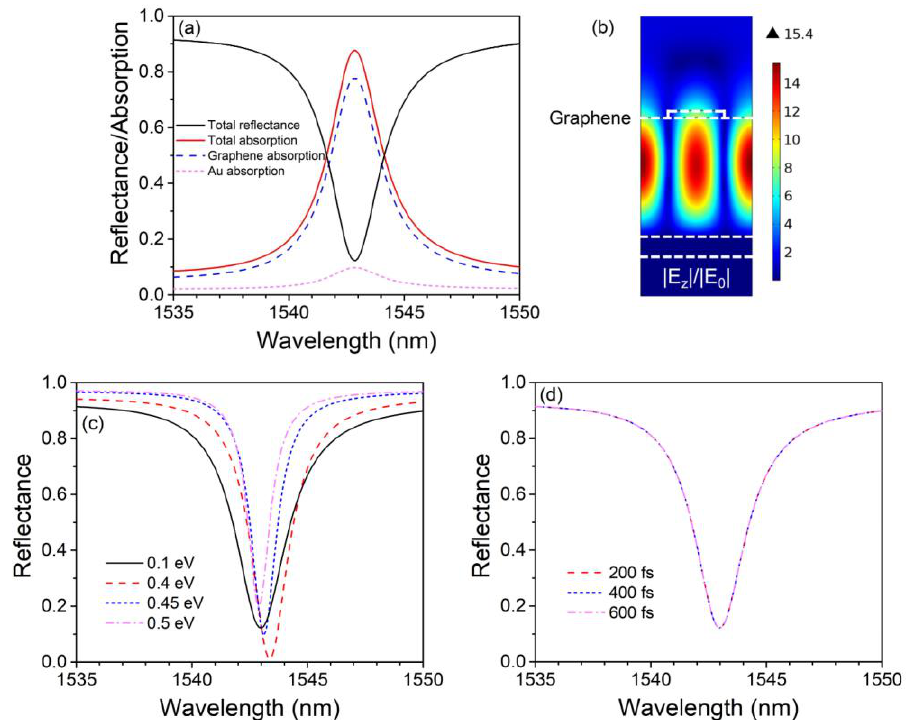
Figure 2. ( a ) Reflectance and absorption spectrums of the graphene-based perfect absorber. The black solid curve, red solid curve, blue dash curve, and magenta short dash curve plot the total reflectance, total absorption, graphene absorption, and gold absorption, respectively. ( b ) Distribution of normalized electric field at 1542.9 nm. ( c ) Reflectance spectrums with different Fermi levels. ( d ) Reflectance spectrums with different relaxation times.